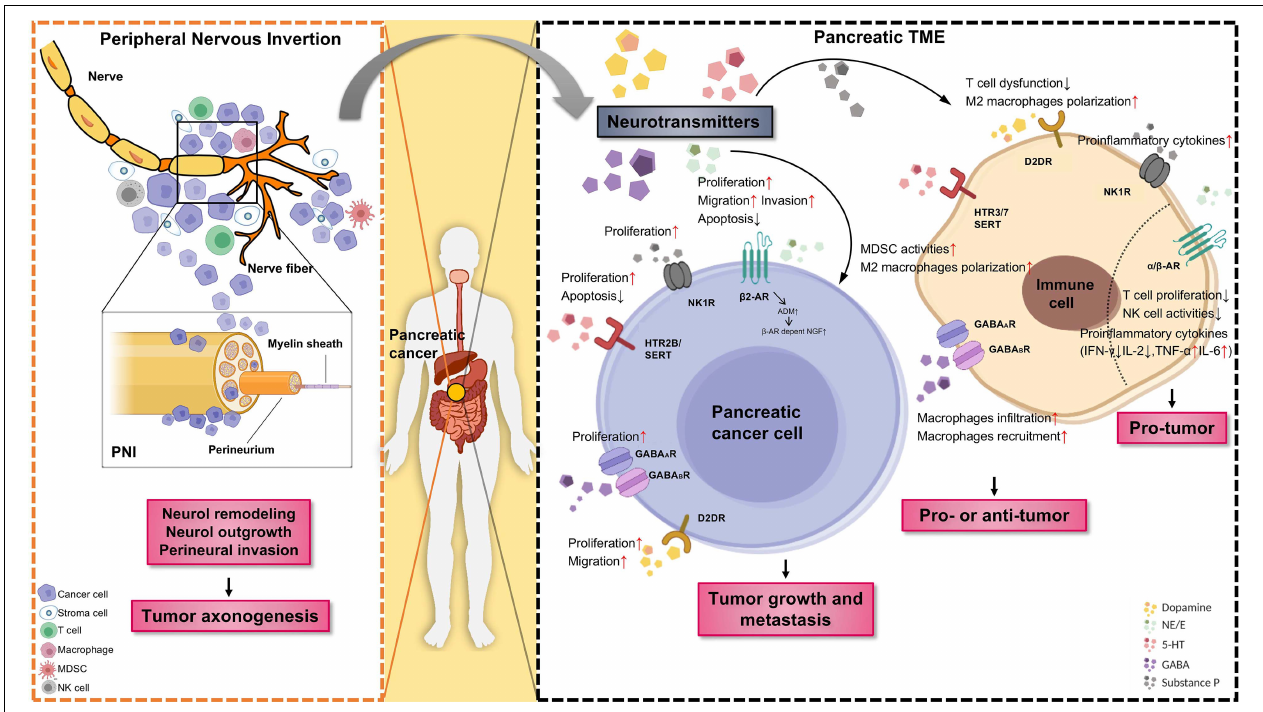
FIGURE 1 | The role of neurotransmitters and the emergence of nerves in the pancreatic tumor microenvironment (TME). Tumor innervation is present as shown by the extension of nerve fibers into the solid tumor, while perineural invasion (PNI) is present as shown by the invasion of cancer cells into the perineurium of the nerve (Left panel) . The outgrowth of nerves in TME (axonogenesis) is partly driven by the secretion of neurotransmitters released by sympathetic nerves and other tissues or cells. In return, nerve fibers as branches of neuron infiltrate the TME, could regulate tumor growth and metastasis. Schematic representation of different neurotransmitters, their respective receptors, target cells as well as pro/antitumor activity of specific neurotransmitter/receptor axis (Right panel) . Neurotransmitters are an active component of the TME. Neurotransmitters released by neuro-endocrine-immune system and other tissues or cells can promote cancer cell proliferation, migration, and invasion through the stimulation of specific membrane receptors. Moreover, immune cells infiltrated in the TME likewise express diverse neurotransmitter receptors and react with neurotransmitter, are known to have a strong impact on tumor angiogenesis and inflammation. PNI, perineural invasion; TME, tumor microenvironment; MDSC, myeloid-derived suppressor cells. The figure was created with